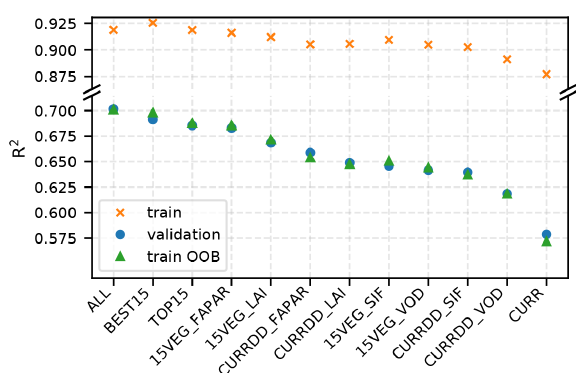
Figure 1. Global climatological R 2 scores for the different ex- periments. The CURR model is the only model that does not in- clude antecedent conditions, and it performs much worse as a re- sult. Despite the fact that the ALL model contains 50 predictors, while all other models contain just 15, it does not perform signifi- cantly better than the best models containing just 15 predictors (e.g. 15VEG_FAPAR). Note that although train R 2 scores are shown here, they are not indicative of model performance on unseen data, for which the shown train OOB scores should be used